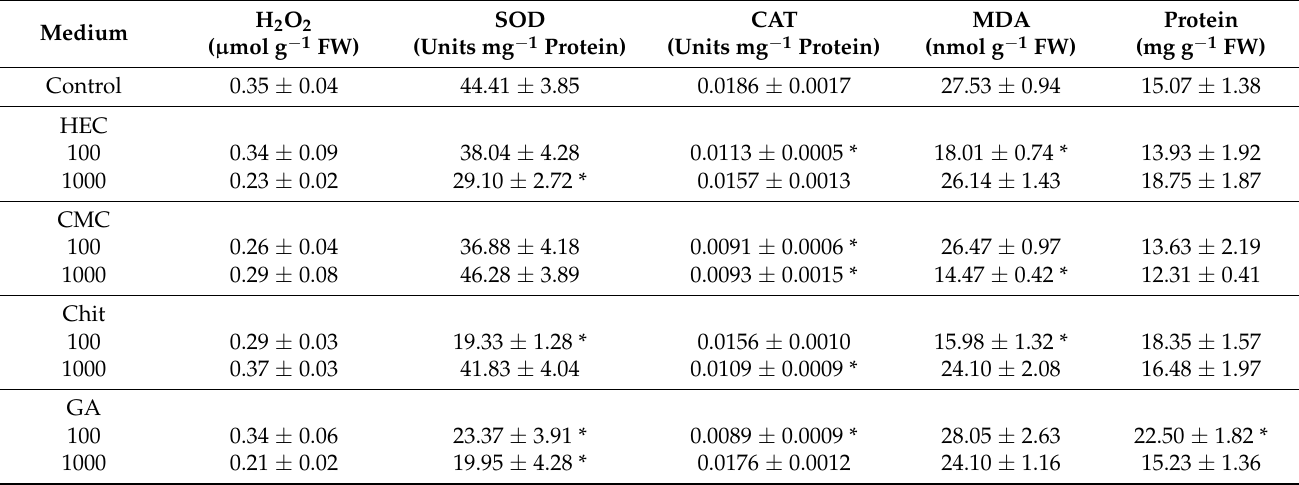
Values are expressed as the mean ± SE. For each parameter, the asterisks (*) indicate differences from the control using Dunnett’s test at p < 0.05. CAT: catalase; CMC: carboxymethylcellulose sodium salt; Chit: chitosan; GA: gum arabic; HEC: hydroxyethyl cellulose; H 2 O 2 : hydrogen peroxide; MDA: malondialdehyde; SOD: superoxide dismutase; 100: 100 mg L − 1 ; 1000: 1000 mg L − 1